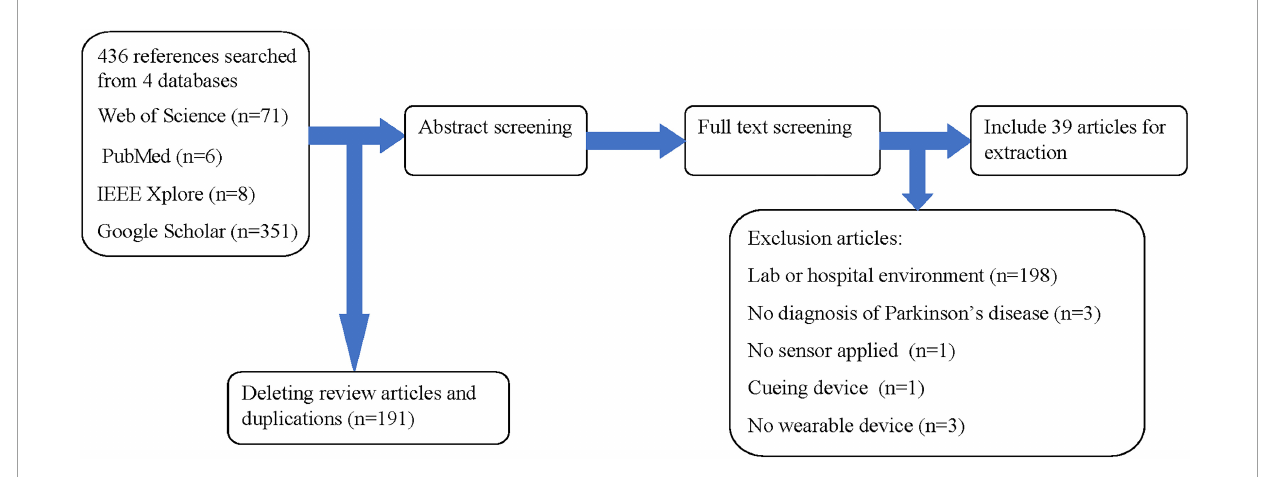
FIGURE1 Reference selection and inclusion/exclusion procedure for this